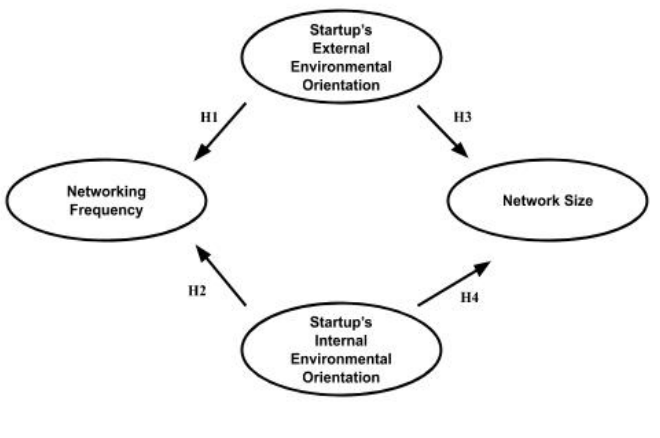
Figure 1: Proposed conceptual